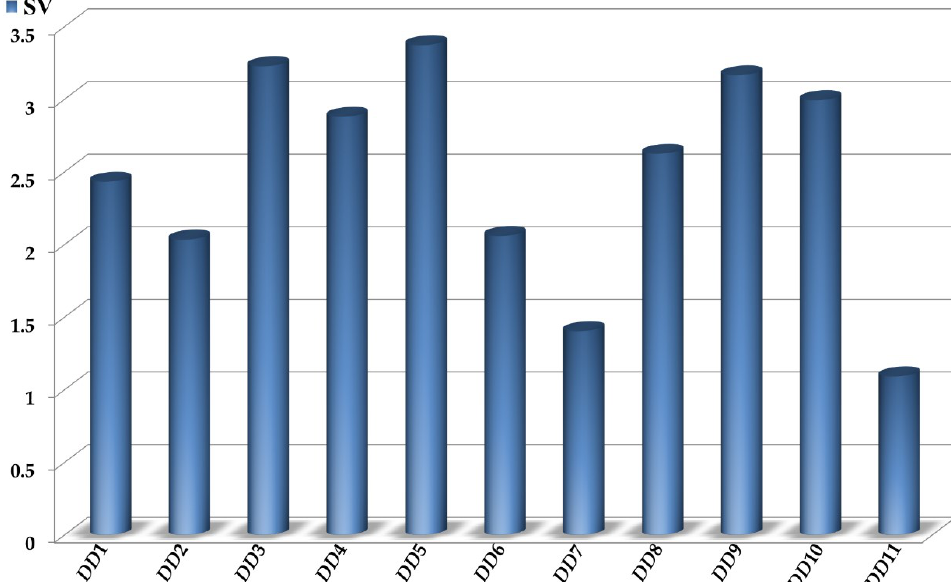
Figure 2. Relative importance of the D [ GTI ] cj descriptors in the mtc-QSAR-MLP model. The following abbreviations are used: DD 1 = D [ Xv ( PC )6] tg , DD 2 = D [ Xv ( Ch )6] tg , DD 3 = D [ e ( Ch )5] tg , DD 4 = D [ NSM ( Hyd )3] tg , DD 5 = D [ NX ( P )6] tg , DD 6 = D [ Ne ( P )2] tg , DD 7 = D [ SM ( Psa )7] ei , DD 8 = D [ e ( C )4] ei , DD 9 = D [ NSM ( Mol )1] ei , DD 10 = D [ NSM ( Ato )1] ei , and DD 11 = D [ NSM ( Ato )5] ei .